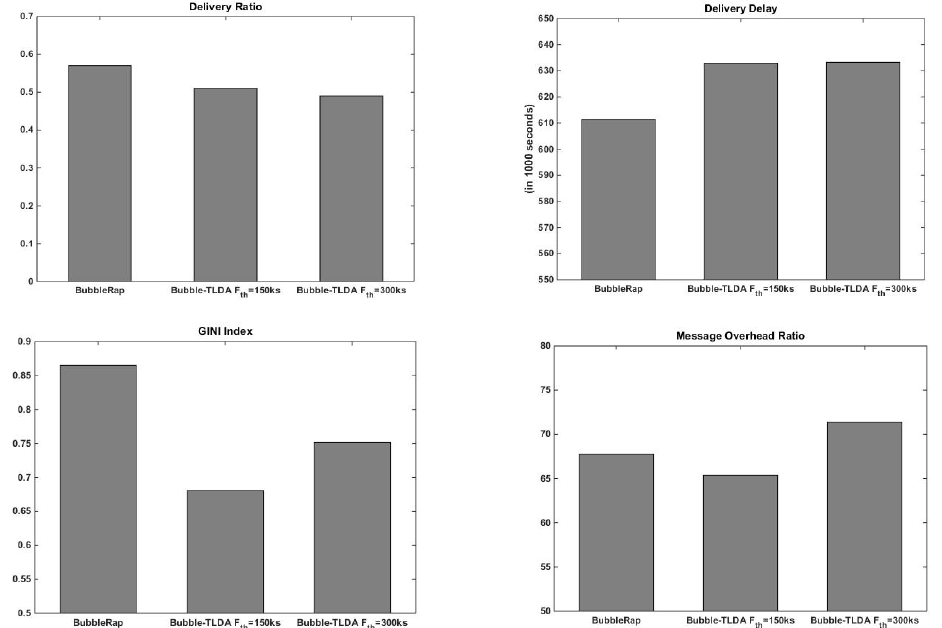
Figure 8. Performance evaluation of BubbleRap and Bubble-TLDA ( 𝜉 = 0.8 ) for the Reality mobility scenario, comparing the delivery performances of BubbleRap and its improved version, Bubble- TLDA. Bubble-TLDA significantly decreases of the GINI index of BubbleRap in this case, without negatively impacting other delivery performances.